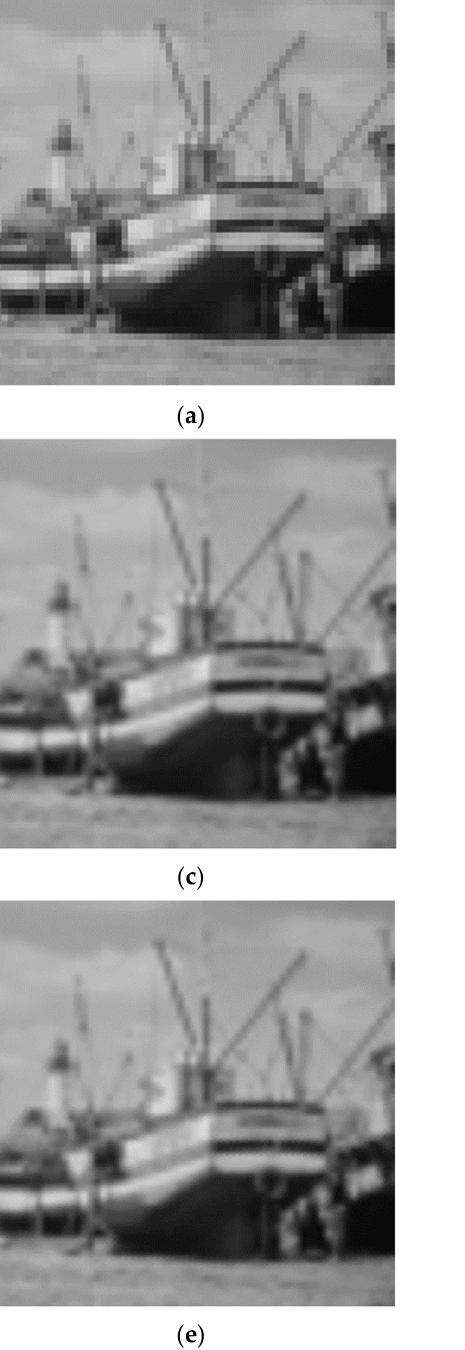
Figure 14. The interpolating image upscaling with a factor of four: ( a ) nearest neighbor; ( b ) bilinear; ( c ) bicubic; ( d ) bicubic Hermite; ( e ) Karim and Saaban [11]; ( f ) the proposed method.